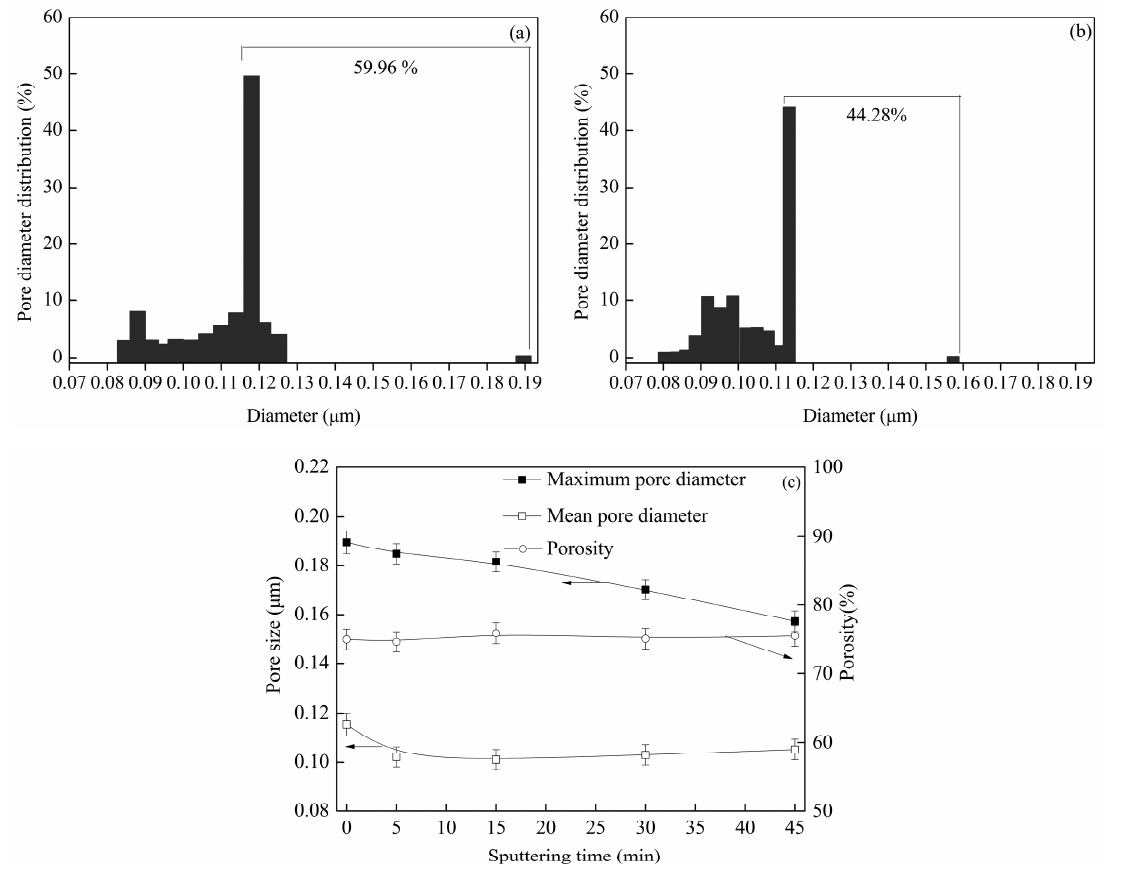
Figure 4. Pore diameter distribution of ( a ) M0 and ( b ) M45 and the ( c ) porosity, maximum pore diameter, and mean pore diameter of the metalized membranes with different sputtering times.